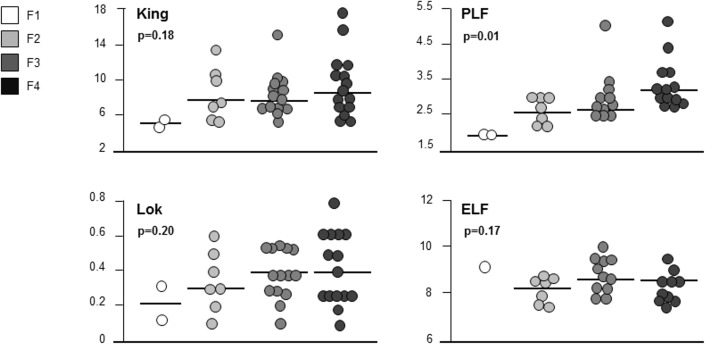
Non-invasive Tests (NITs) values stratification according to post-SVR fibrosis stage.